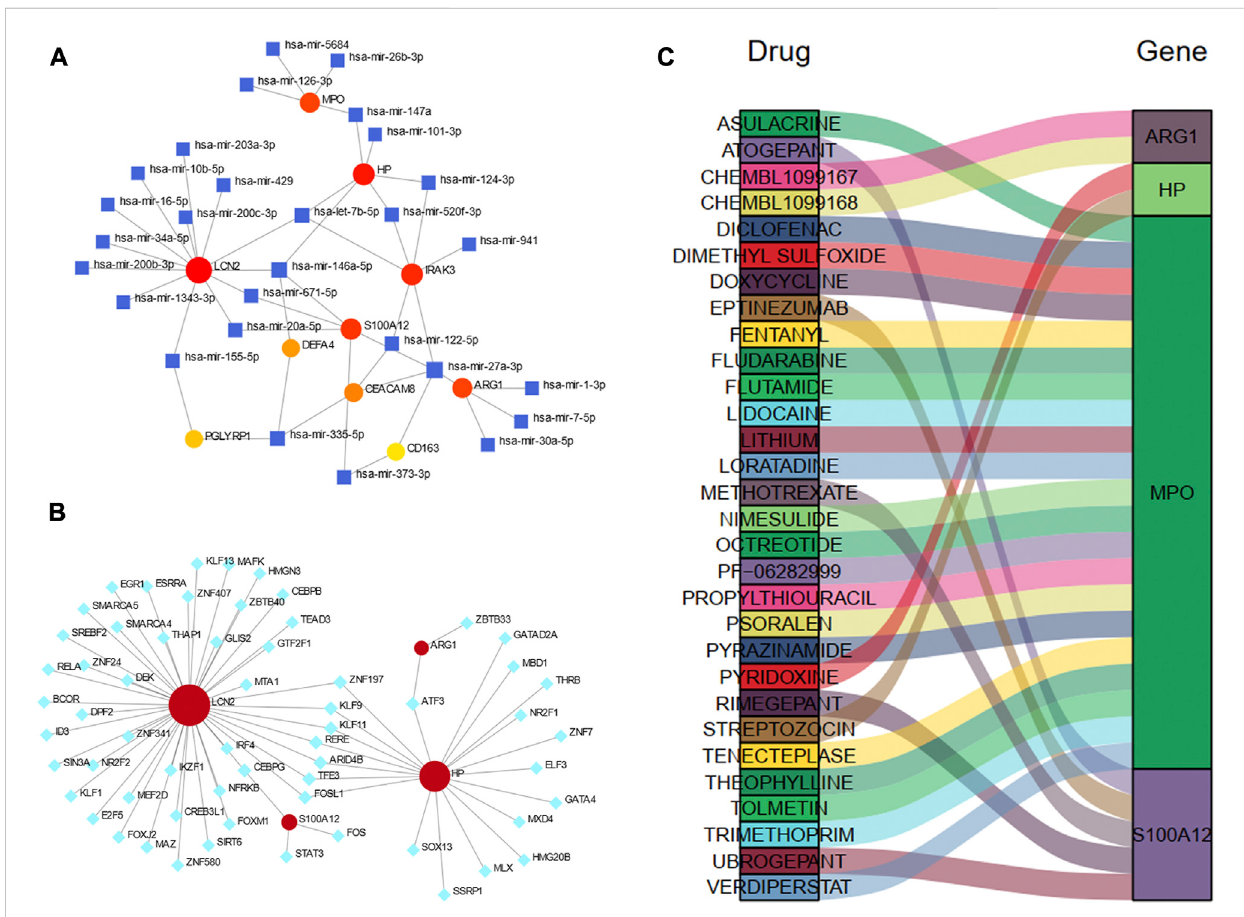
FIGURE 9 Constructionoftheregulatorynetwork forhubgenes. (A) gene-miRNAsinteractions. (B) gene-TFsinteractions. (C) A Sankeydiagramindicating the potential drugs for hub genes. The circle nodes represent the hub genes. The square nodes represent miRNAs. The diamond nodes represent TFs. TF, transcription